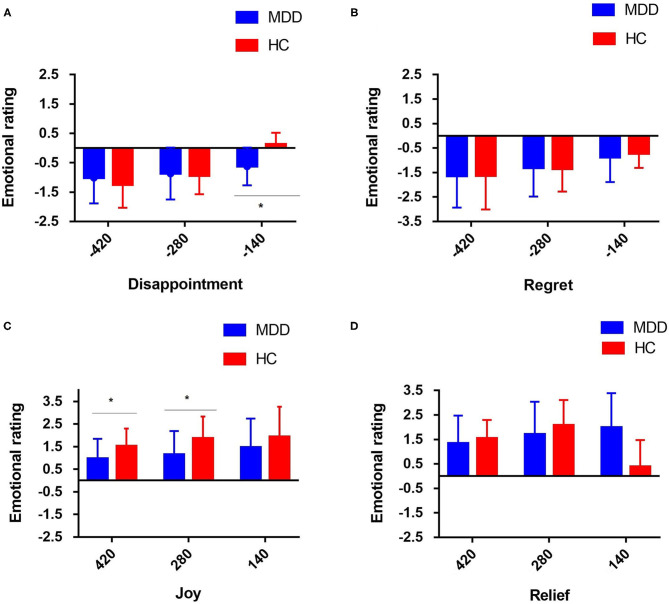
Mean individual emotion rating for the four different events (note: disappointment and joy refer to the intra-option comparison in the situation-focused CT, while regret and relief refer to the inter-choice comparison in the behavior-focused CT for the two groups of participants. For situation-focused CT, the participant could experience disappointment
(A) in the case of relative loss, i.e., the obtained outcome is worse than the non-obtained outcome of the selected wheel, or joy
(C) in the case of relative gain, i.e., the obtained outcome is better than the non-obtained outcome of the selected wheel. For example, intra-option comparison: loosing 70 when they could have lost 210 was classified as a relative gain, and winning 70 when they could have won 210 was classified as a relative loss. For the behavior-focused CT, information on the outcome of the unselected wheel is available, and the participant could experience regret
(B) when the obtained outcome is worse than that of the unselected wheel or relief
(D) when the obtained outcome is better than that of the unselected wheel (i.e., inter-choice comparison) (*p < 0.05. The emotion scale ranged from−5 [extremely negative] to +5 [extremely positive]).